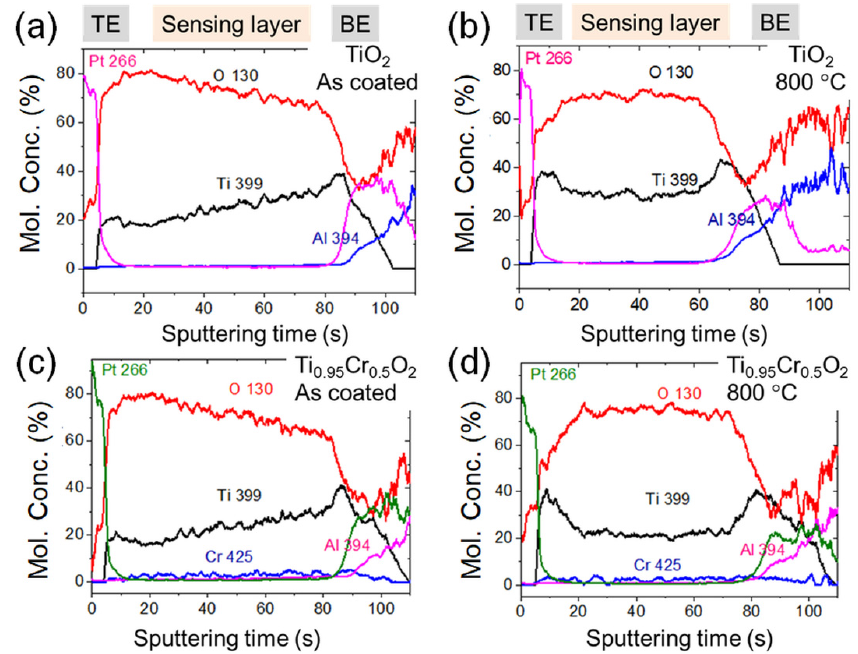
Figure 5. The glow discharge optical emission spectroscopic plots showing the quantitative analysis of evolution of composition of the various elements (Pt, Ti, O, and Cr) in the pristine TiO 2 sensing layer ( a , b ) and Ti 0.95 Cr 0.5 O 2 ( c , d ) both as-deposited and annealed at 800 ◦ C. The color elemental composition shows the defected sensing layer in the as-deposited state and stoichiometric state at 800 ◦ C annealing with evidence of Cr incorporation into the TiO 2 sensing layer.